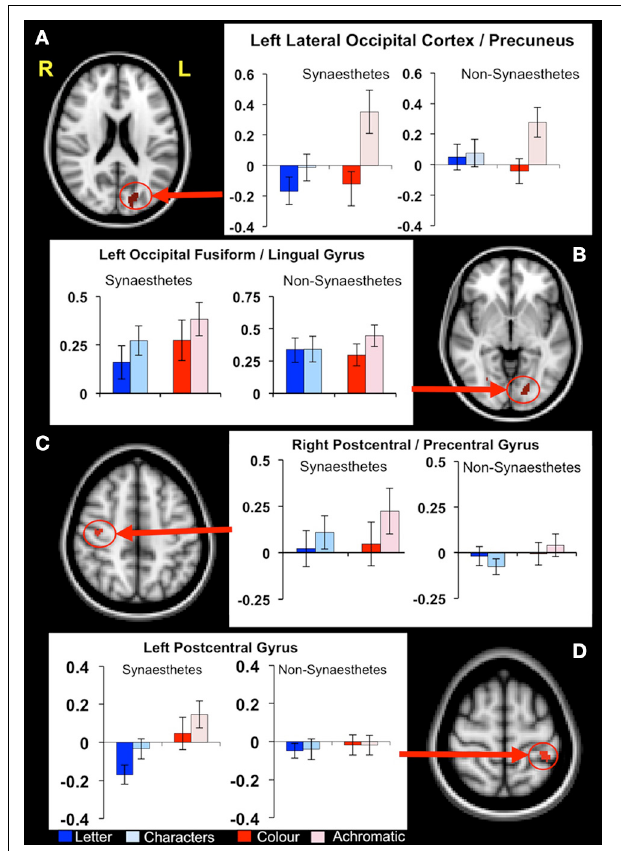
FIGURE 4 | Functional differences in structurally defined regions of interest. Four clusters of significantly increased GM volume in synaestehetes showed a significant group × condition interaction for the letter/non-meaningful characters contrast. Mean fMRI task activations within these ROIs are detailed for each task condition (letter/character and color/achromatic) in synaesthetes and controls. Two clusters, in left lateral occipital cortex/precuneus panel (A) and in left post-central gyrus panel (D) showamaingroupeffectinresponsetoletters(bluebars).Thesedifferences are driven by a strong negative BOLD response to letters in synaesthetes. The other two clusters, in left occipital fusiform/lingual gyrus (B) and right postcentral/precentral gyrus (C) did not show a main group effect for